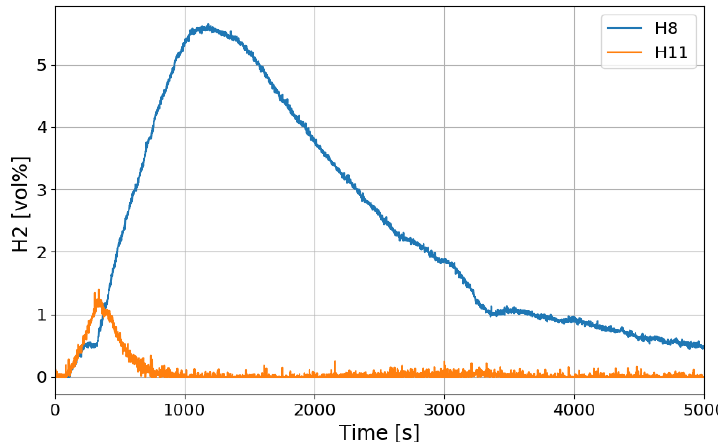
Figure 17. Hydrogen concentrations at inlet and outlet of the PAR for the SP3 test, H8: inlet, H11: outlet.